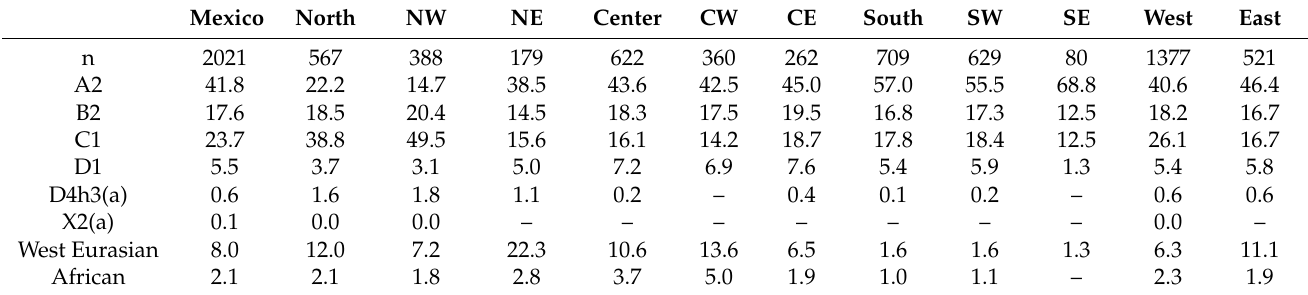
Table 1. MtDNA haplogroups in 2021 Mexican individuals. Proportions [%] of Indigenous American haplogroups and other contributions to the Mexican mtDNA pool in the 2021 individuals included in this study 1 and geographic subsets 2 . See text for